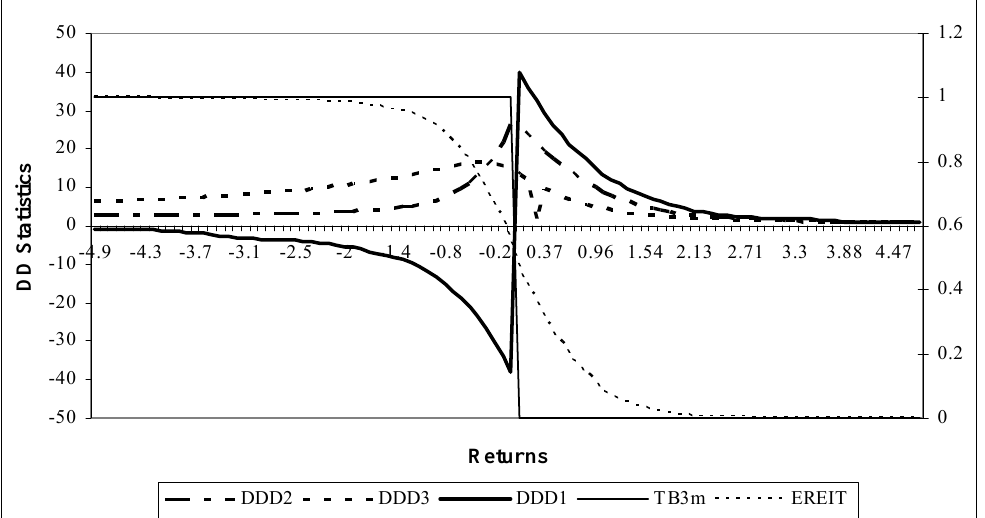
Figure 4: Descending CDF and DD Statistics Between Equity REITs and 3-Month T. Bill for